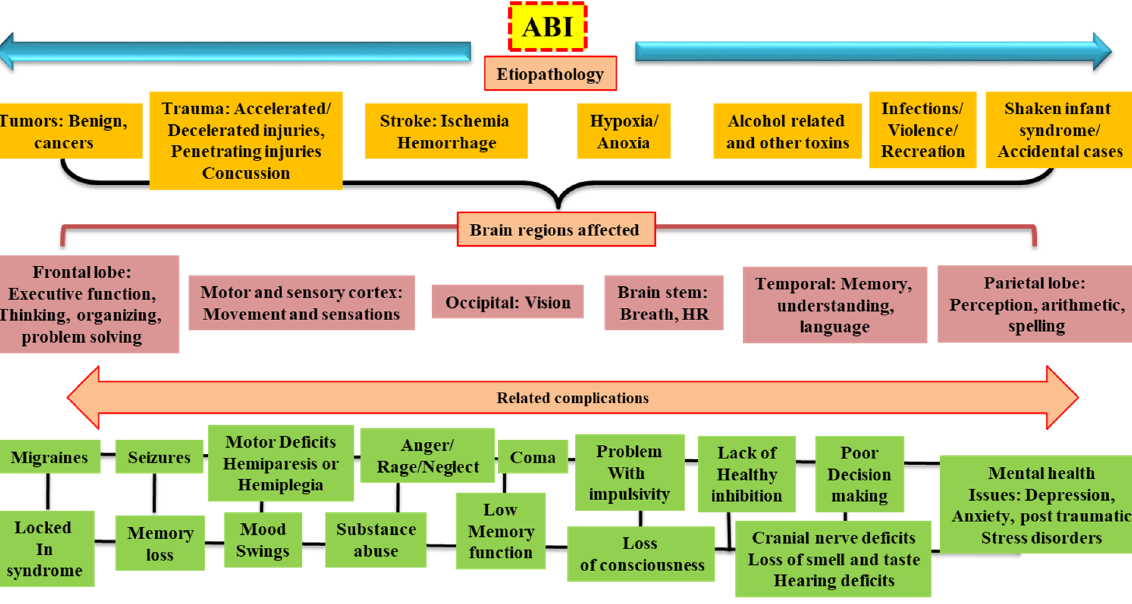
Figure 1. ABI: Etiopathology, classifications, the brain region affected, and related complications. The pictorial presentation of ABI describes its type (purple) and etiology of the disease (in orange texts). ABI is mainly divided into TBI and Non-TBI injuries. Non-TBI can arise from tumors, vessel occlusion, infection, or alcohol consumption. ABI can affect different regions of the brain depending on impact, insult, infection, or blockage (shown in pink) and may show related signs and symptoms (depicted in green). HR: Heart rate.